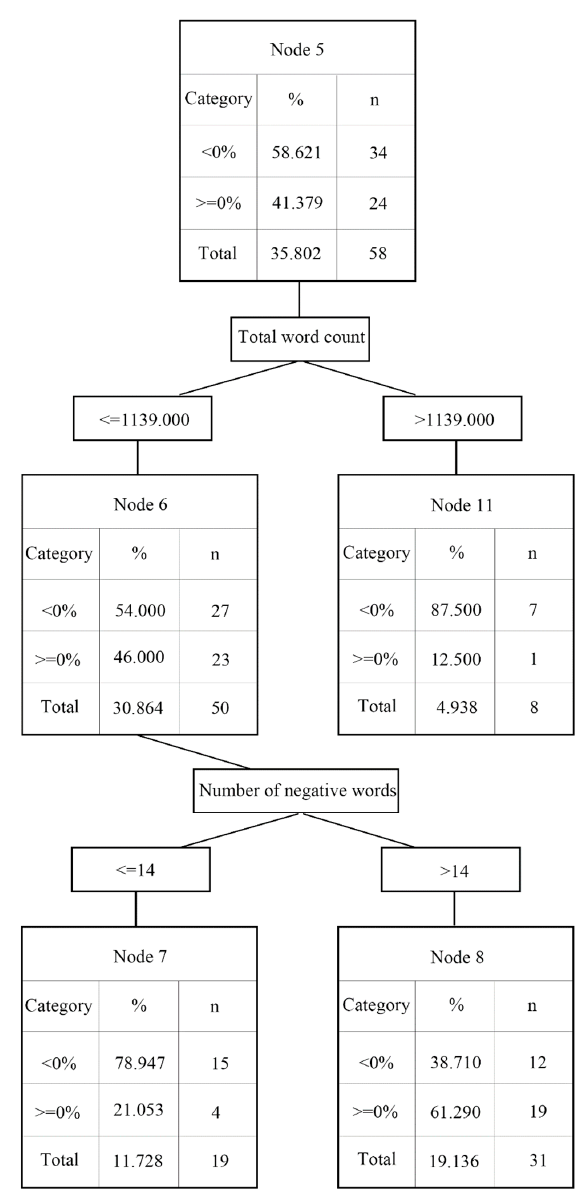
Figure 6. The classification results for N03 (The Wall Street Journal) at Nodes 5, 6, 7, 8, and 11.